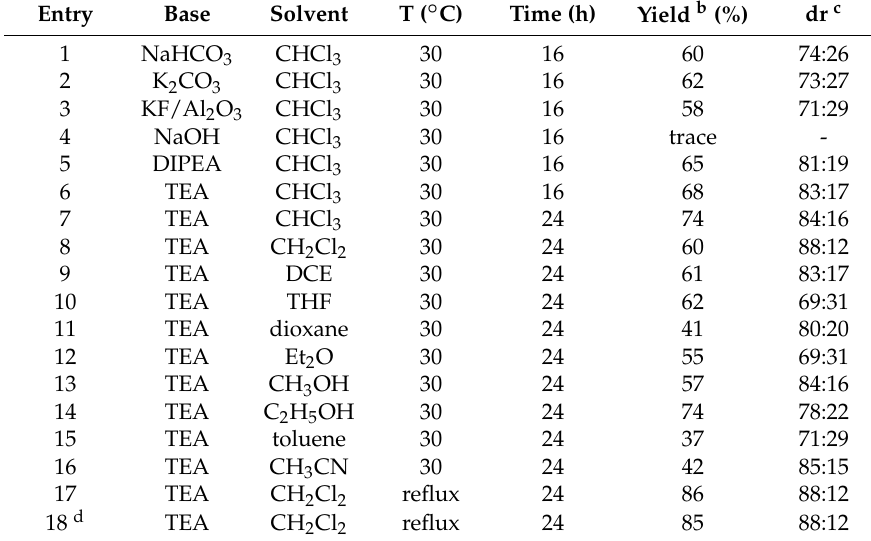
Table 1. Optimization of reaction conditions a .